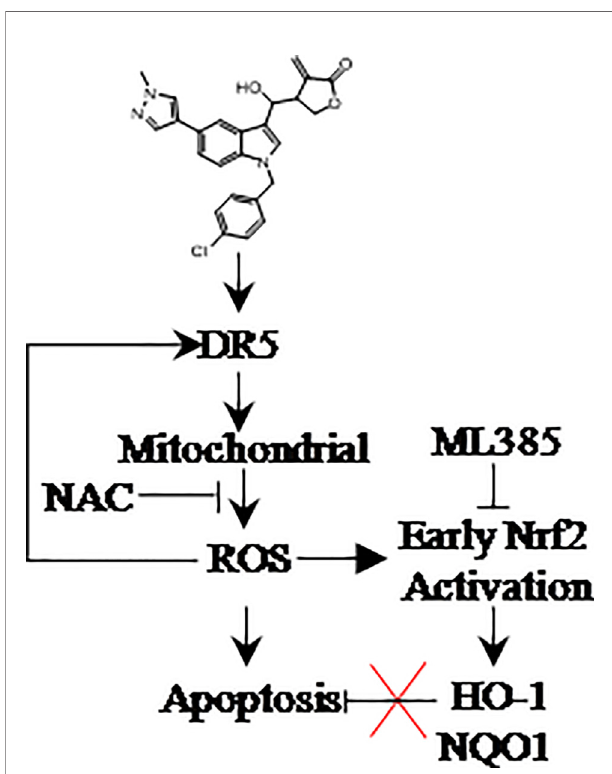
FIGURE 7 | LCT-3d selectively kills gastric cancer cells but not normal cells via inducing ROS triggered apoptosis by activating death receptors and the mitochondria pathway. ROS scavenger NAC can block cell death, while Nrf2 inhibitor ML385 has no effect on LCT-3d-induced cell death. The promotion of ROS-induced apoptosis by LCT-3d depends on the up-regulation of DR5 but not the inactivation of